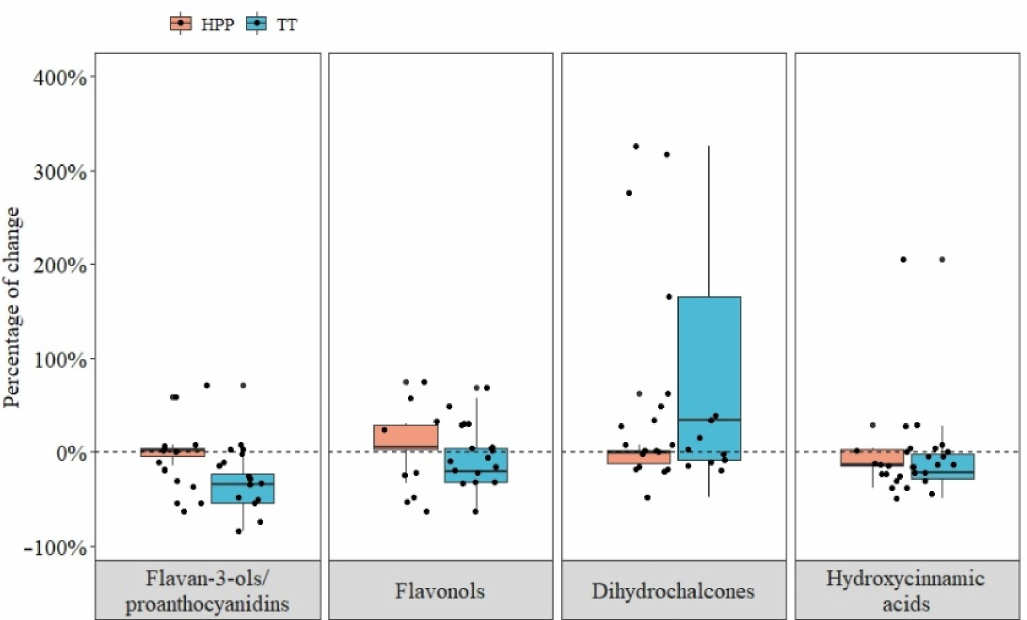
Figure 4. Impact of thermal treatment (TT) and high-pressure processing (HPP) on total flavan-3-ols/proanthocyanidins, flavonols, dihydrochalcones, and hydroxycinnamic acids after different processing conditions in apple products. Each point represents the results of a trial. The percentages of change with the processing of each polyphenol family were calculated by adding the concentration of all polyphenols from the same family and comparing it before and after processing. In TT, one trial with a percentage of change of F3OLs/PACs of 1800%, another with a percentage of change in DHCs of 768%, and another one with a percentage of change of HCAs of 925% were removed from the figures for scale